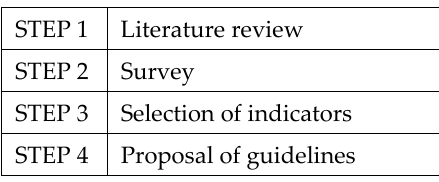
Figure 2. Research method.